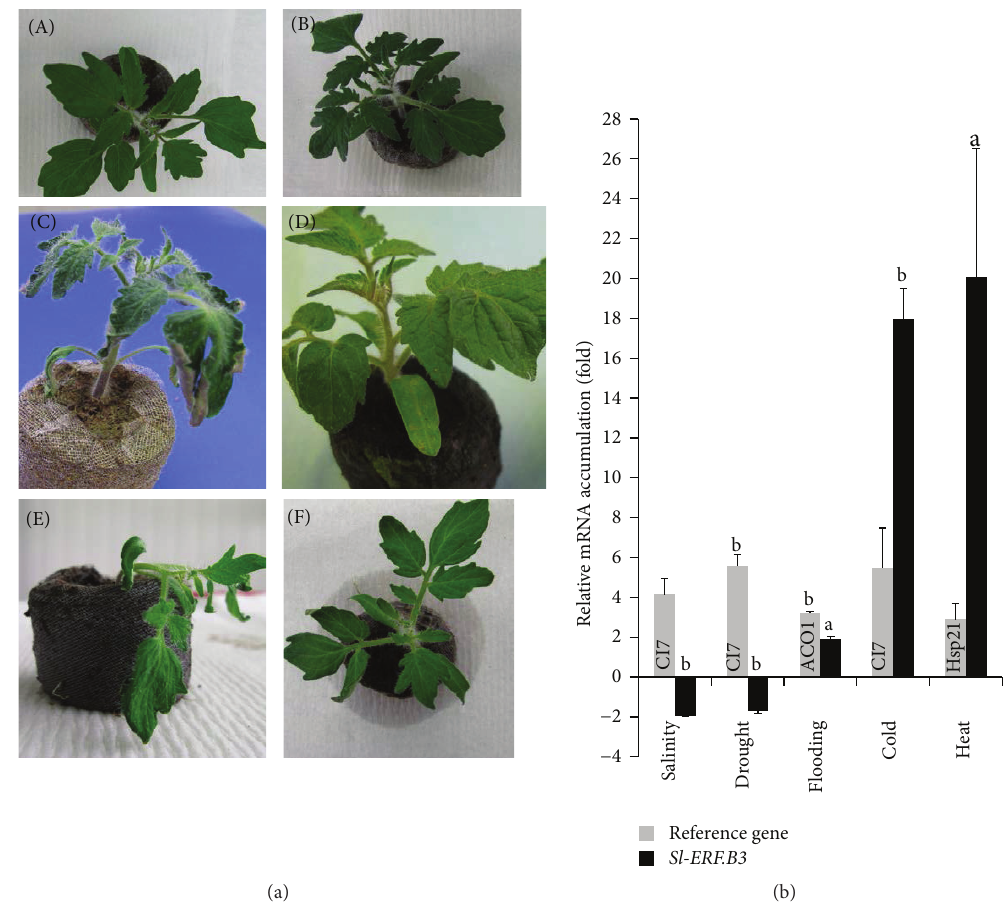
Figure 1: Expression pattern of Sl-ERF.B.3 gene, in aerial parts of wild type tomato plants, in response to five abiotic stresses. Transcripts accumulation was assessed by quantitative real time PCR, as described in material and methods, using total RNA samples extracted from shoots of three weeks old wild type tomato plants: treated by 4 ∘ C for 8 h (cold), stored at 42 ∘ C for 8h (heat), watered by 200 mM NaCl solution during 24 h (salinity), watering deprived during 5 d (drought), or root inundated during 72 h (flooding). (a) Plants used for RNA extraction refer to those stress treated (by salinity (B); by drought (C); by flooding (D); by cold (E); or by heat (F)) and (A) for no stress-control. For each case one representative plant is presented. (b) The stress treatments effect on Sl-ERF.B.3 and three reference genes ( CI7, ACO1, and Hsp21 ) expression level. The Sl-actin-51 transcripts in the same samples were used as internal control. Data are expressed as relative values, based on the values of control taken as reference sample set to 1.0. Pairwise comparisons were made between control and abiotic stress treated wild-type plants with Student’s 𝑡 -test (a: 𝑃 < 0.05 , b: 𝑃 < 0.01 ). Data represent means and standard error of three